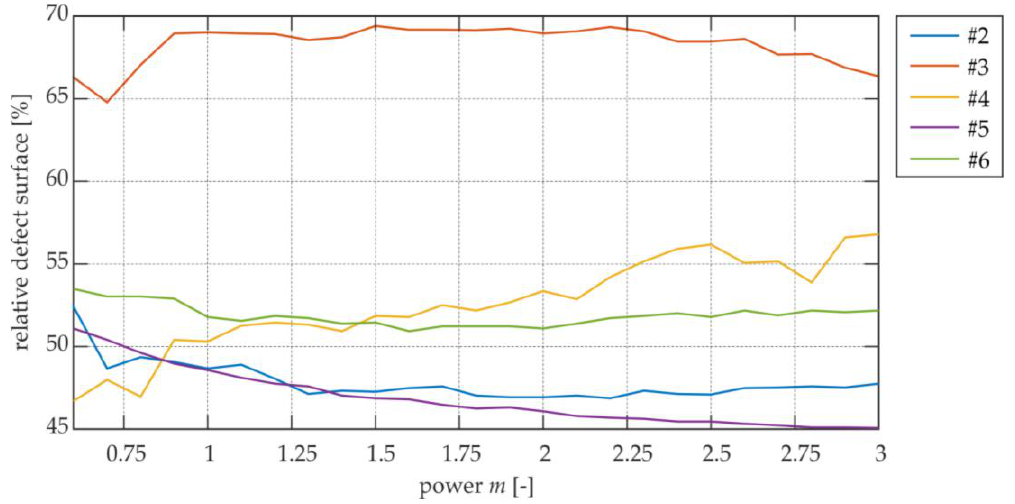
Figure 19. Relationships between the relative defect surface and weighting factor (represented by power m ) for specimens